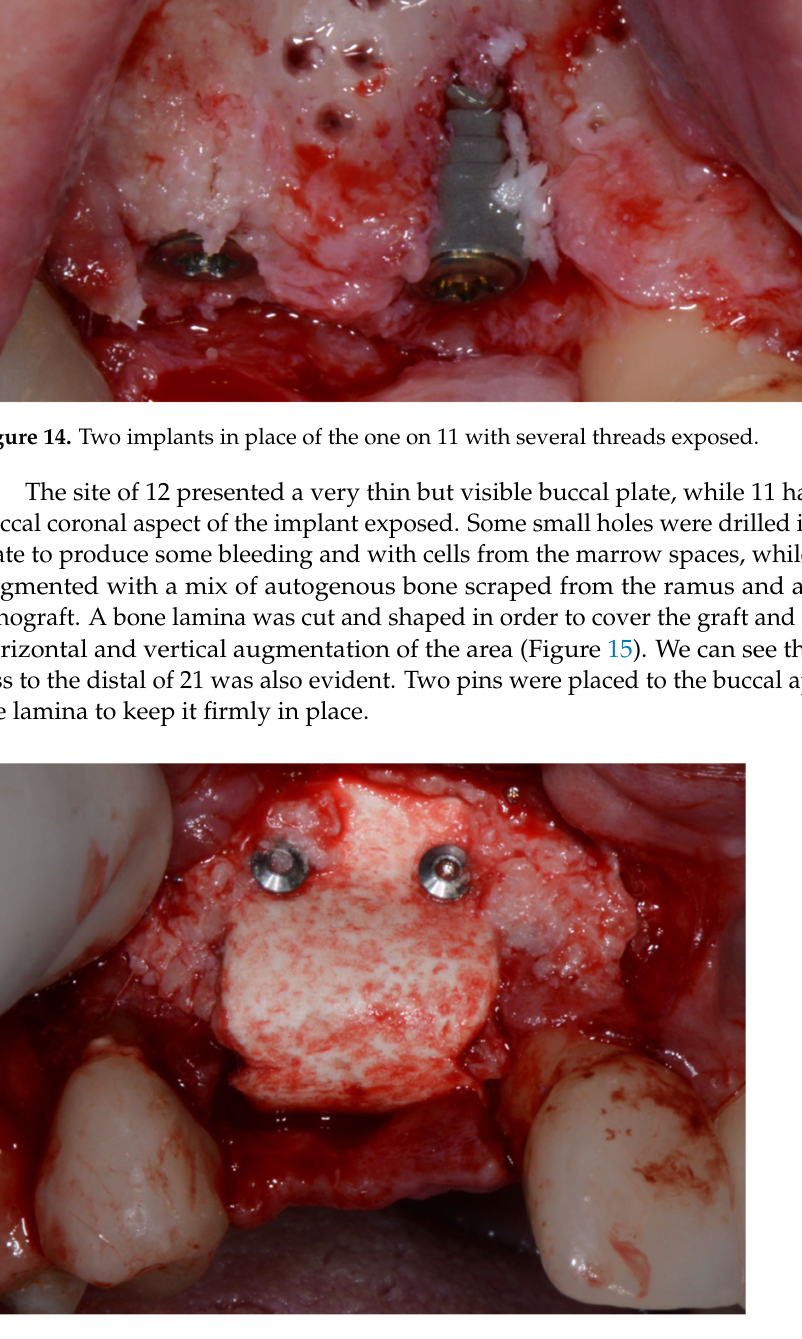
Figure 15. The bone lamina stabilized to protect the two implants. Six months after surgery the area looked healthy and the dimensions restored (Figure